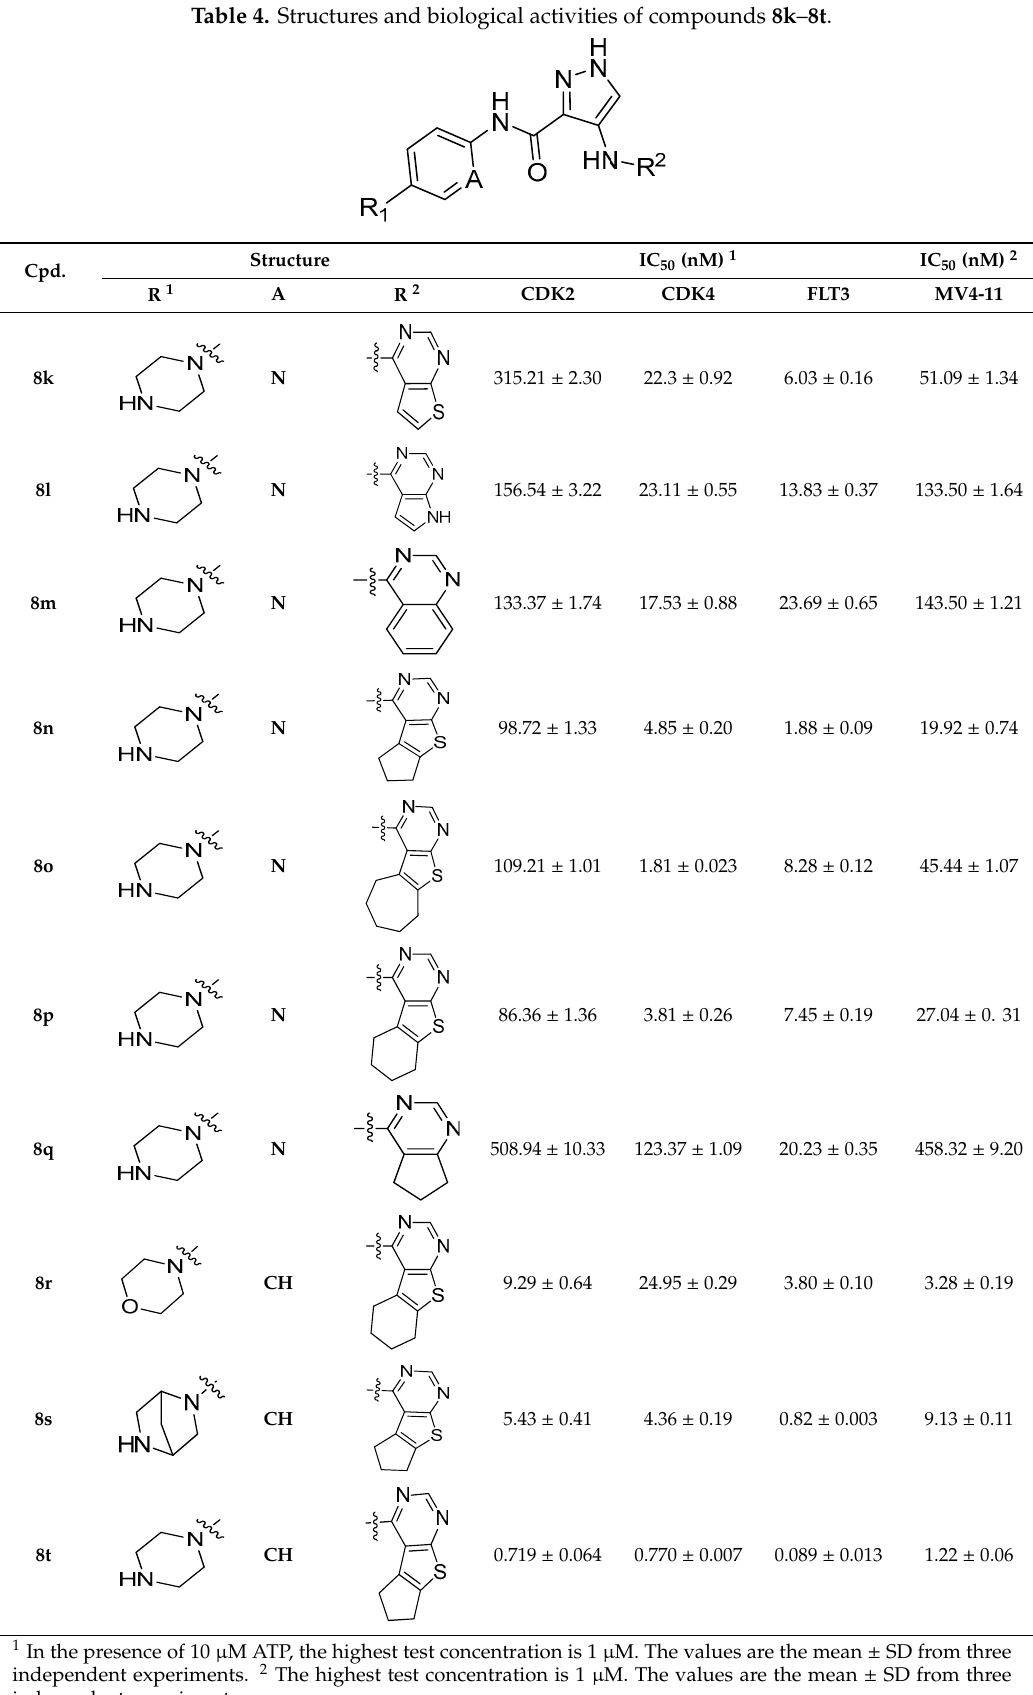
Table 4. Structures and biological activities of compounds 8k – 8t .